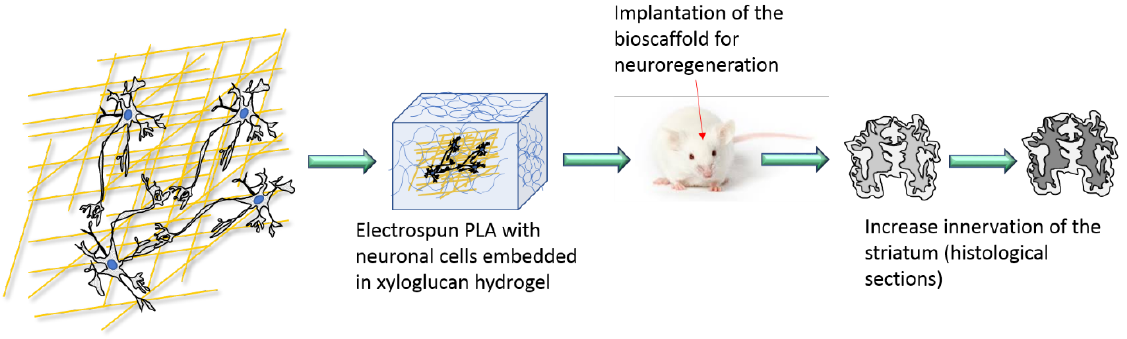
Figure 5. Electrospun polylactic acid (PLA) loaded with neuronal cells and embedded into a xyloglucan hydrogel for the neuro-regeneration of mice animal model by increasing the innervation of the striatum tissue of the brain. Freely adapted from Wang et al. 2016 [219] .